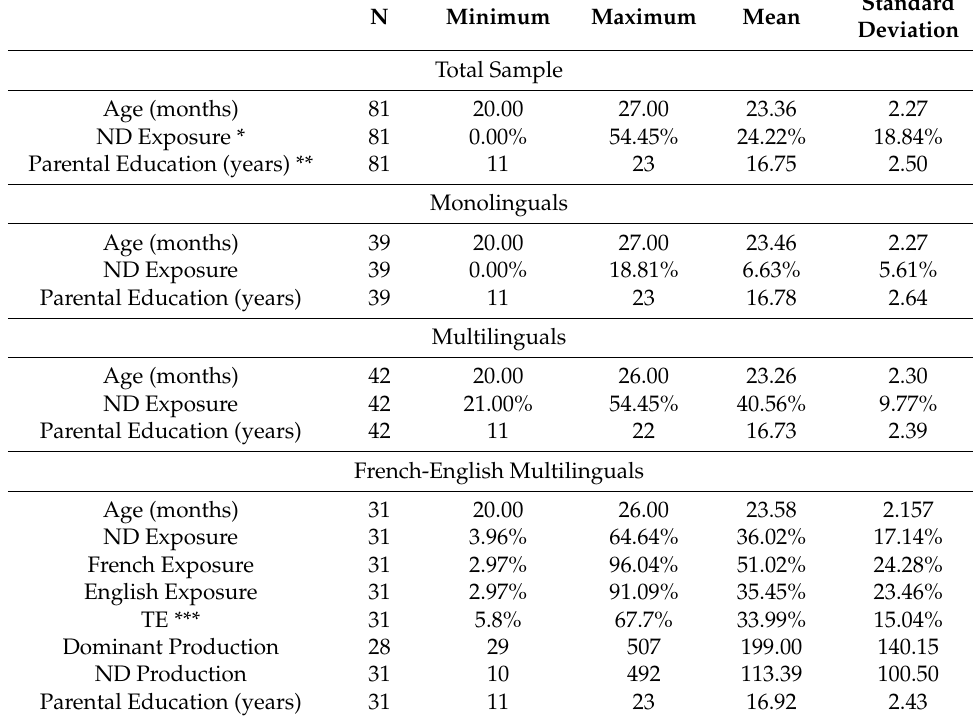
Table 1. Descriptive